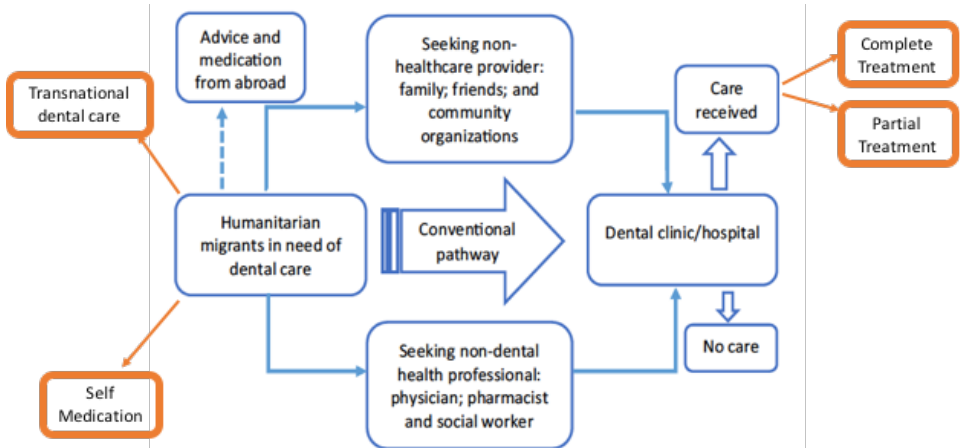
Figure 1. An updated dental care pathways model of humanitarian migrants. Modifications based on the present study are highlighted in orange [12] .